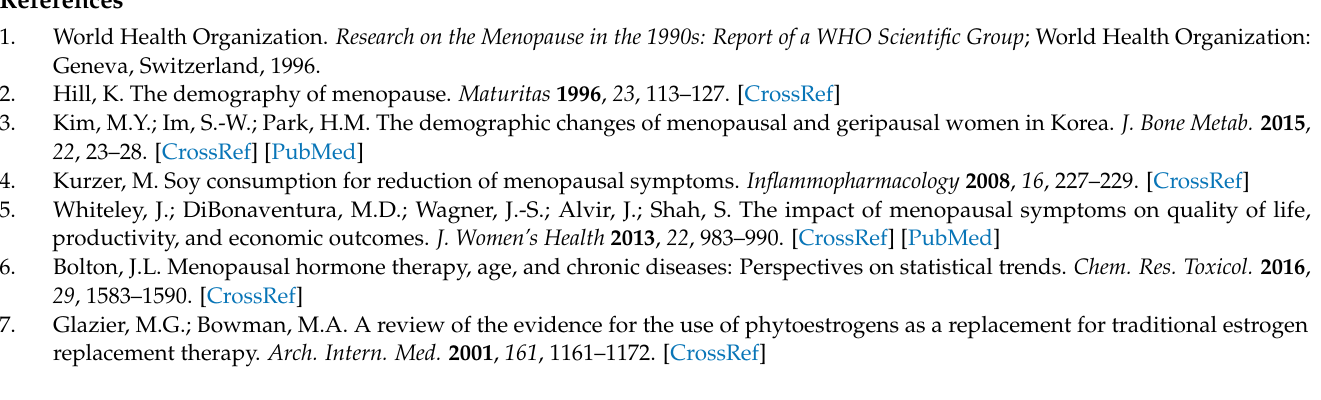
Figure S6: The 1 H NMR spectrum of 5 (CDCl 3 , 700 MHz), Figure S7: The 1 H NMR spectrum of 6 (CDCl 3 , 700 MHz), Figure S8: The 1 H NMR spectrum of 7 (CDCl 3 , 700 MHz), Figure S9: The 1 H NMR spectrum of 8 (CDCl 3 , 700 MHz), Figure S10: Total ion chromatogram (TIC) of compound 1 in the LC/MS analysis, Figure S11: TIC of compound 2 in the LC/MS analysis, Figure S12: TIC of compound 3 in the LC/MS analysis, Figure S13: TIC of compound 4 in the LC/MS analysis, Figure S14: TIC of compound 5 in the LC/MS analysis, Figure S15: TIC of compound 6 in the LC/MS analysis, Figure S16: TIC of compound 7 in the LC/MS analysis, Figure S17: TIC of compound 8 in the LC/MS analysis, Figure S18: UV chromatogram of LC/MS (detection wavelength was set as 254 nm) of (A) hexane-soluble and (B) CH 2 Cl 2 -soluble factions, Figure S19: TLC analysis of (A) hexane-soluble and (B) CH 2 Cl 2 -soluble